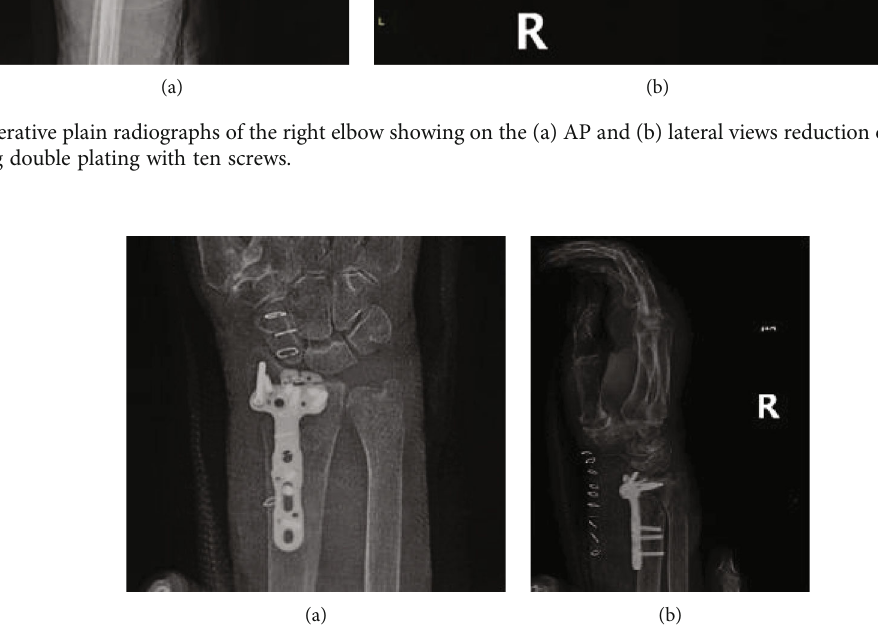
Figure 5: Postoperative plain radiographs of the right wrist showing on the (a) AP and (b) lateral views reduction of the distal radius fracture using a distal volar plate and nine